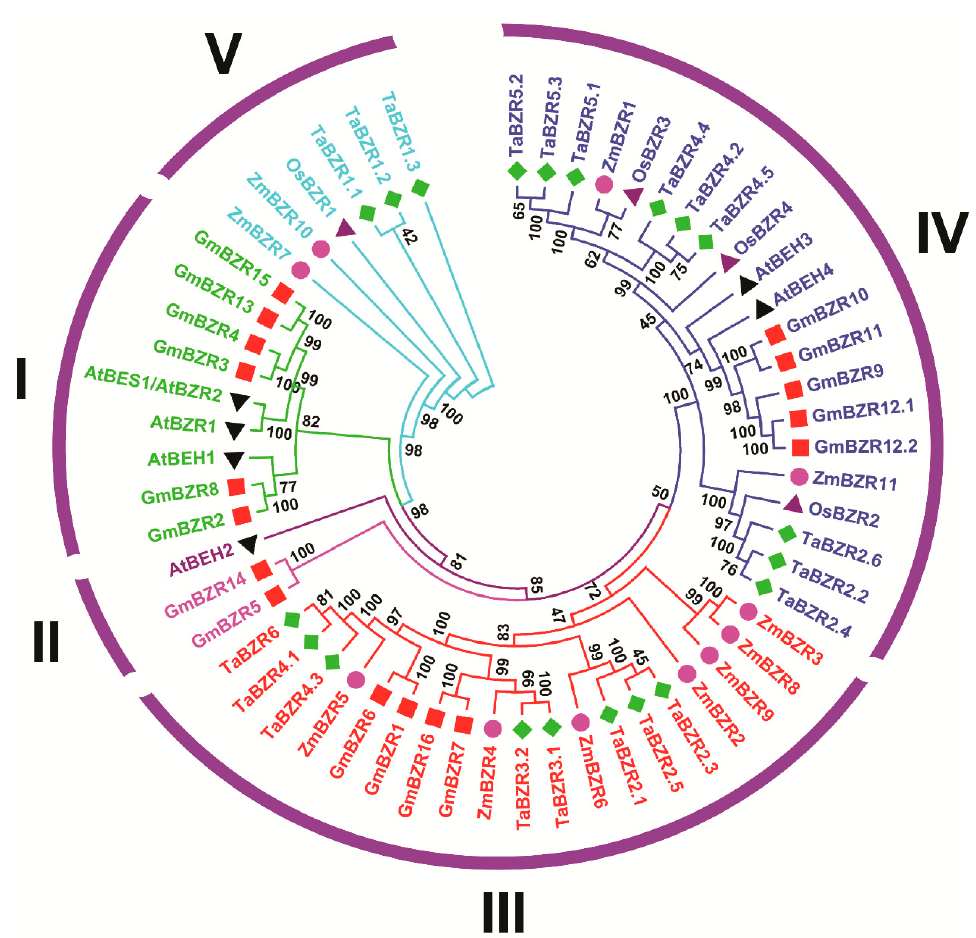
Figure 1. Phylogenetic analysis of BZR proteins among the wheat (20), Arabidopsis (6), maize (11), soybean (16), and rice (4) using the MEGAX by the neighbor-joining method.